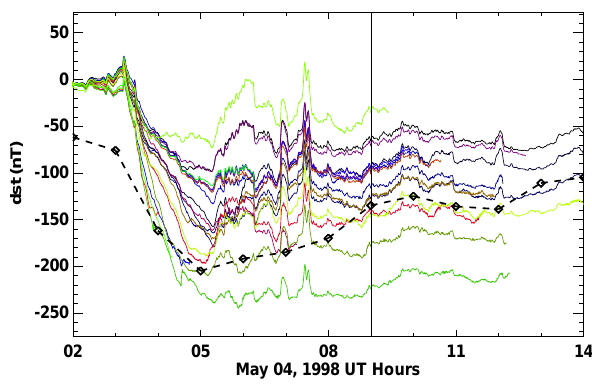
Fig. 14. The measured (dashed black line) and simulated (colored lines) Dst index for the 4 May 1998 storm. The simulated results are described in Table